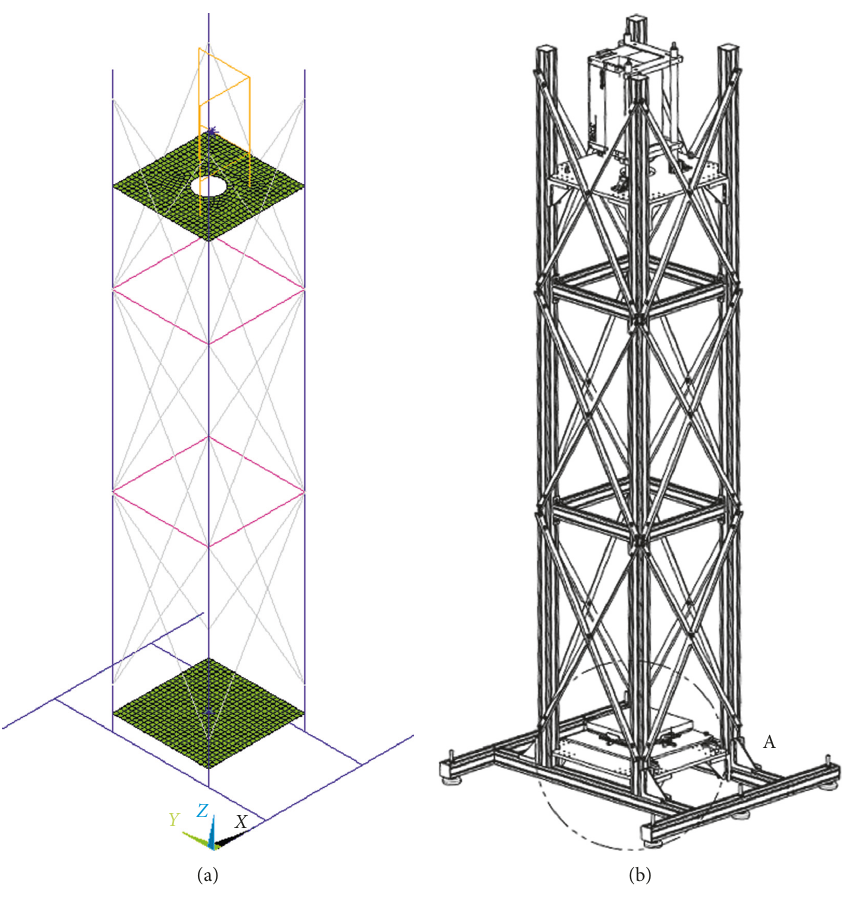
Figure 2: FEA model of the OTS (a) and CAD model (b).